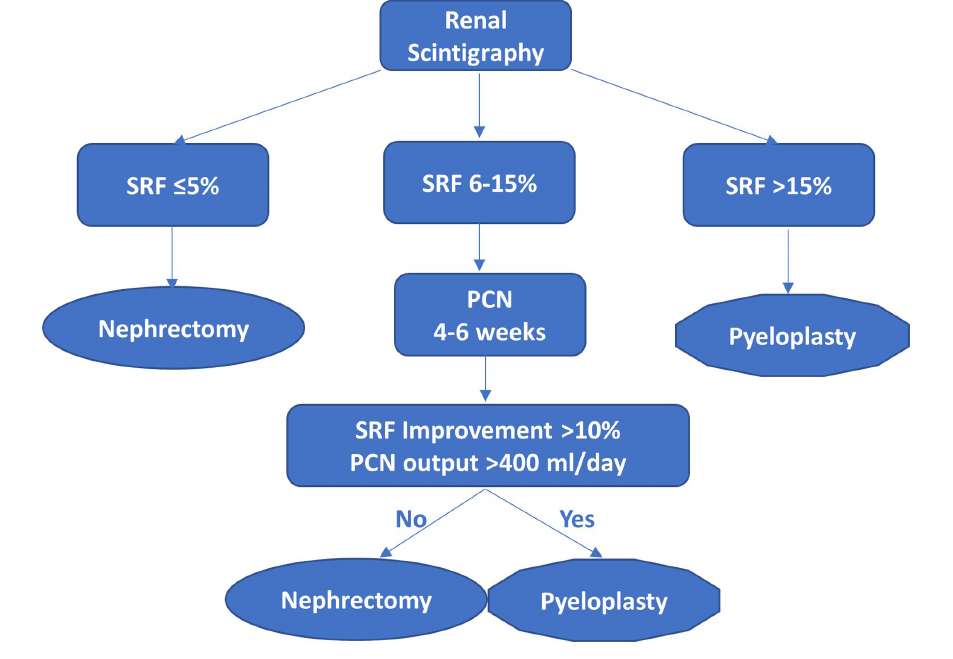
Figure 1. Conclusion from our